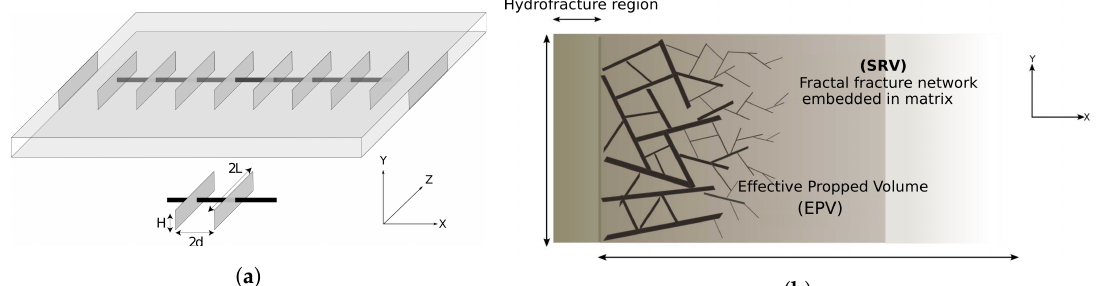
Figure 5. ( a ) A horizontal well with eight hydrofracture stages. The hydrofractures are perpendicular to the wellbore and gas flows into each hydrofracture from both sides. The hydrofracture permeability is infinite relative to the stimulated matrix. Adapted from [56]. ( b ) Planar view of half-SRV after hydrofracturing. The branching fracture network starts at the fracture face and its density decreases away from it. This fracture network interacts with the organic matrix and drains gas into the hydrofracture. The fracture porosity, φ f , and permeability, k f , also decrease as we move away from the fracture face. The Effective Propped Volume (EPV) is defined by the distance d EPV up to which the fractures are connected well enough to drain gas from the local organic